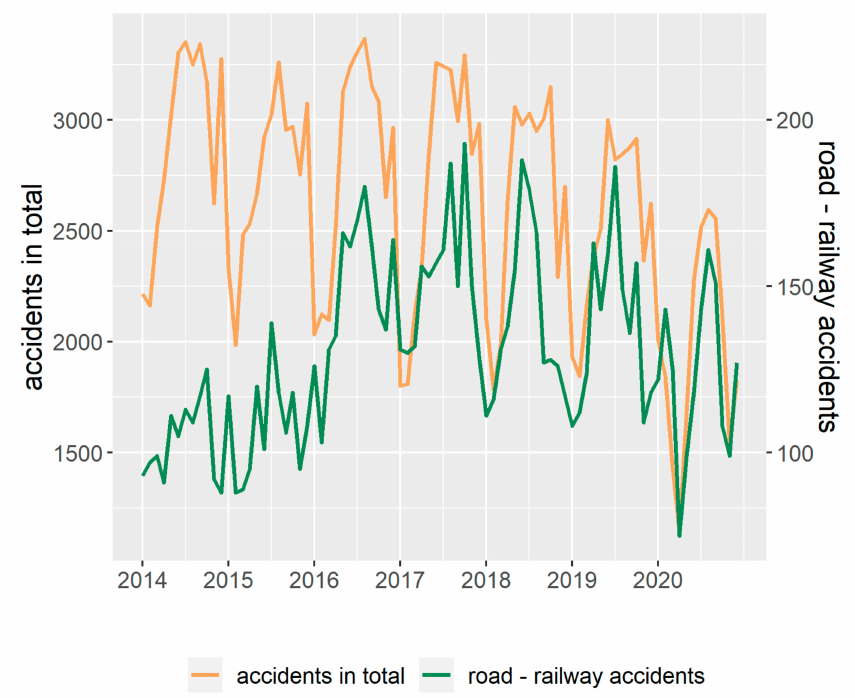
Figure 1. Number of total traffic accidents and road–railway accidents during the studied period. Calculations show that road–rail accidents account for only 5% of all traffic